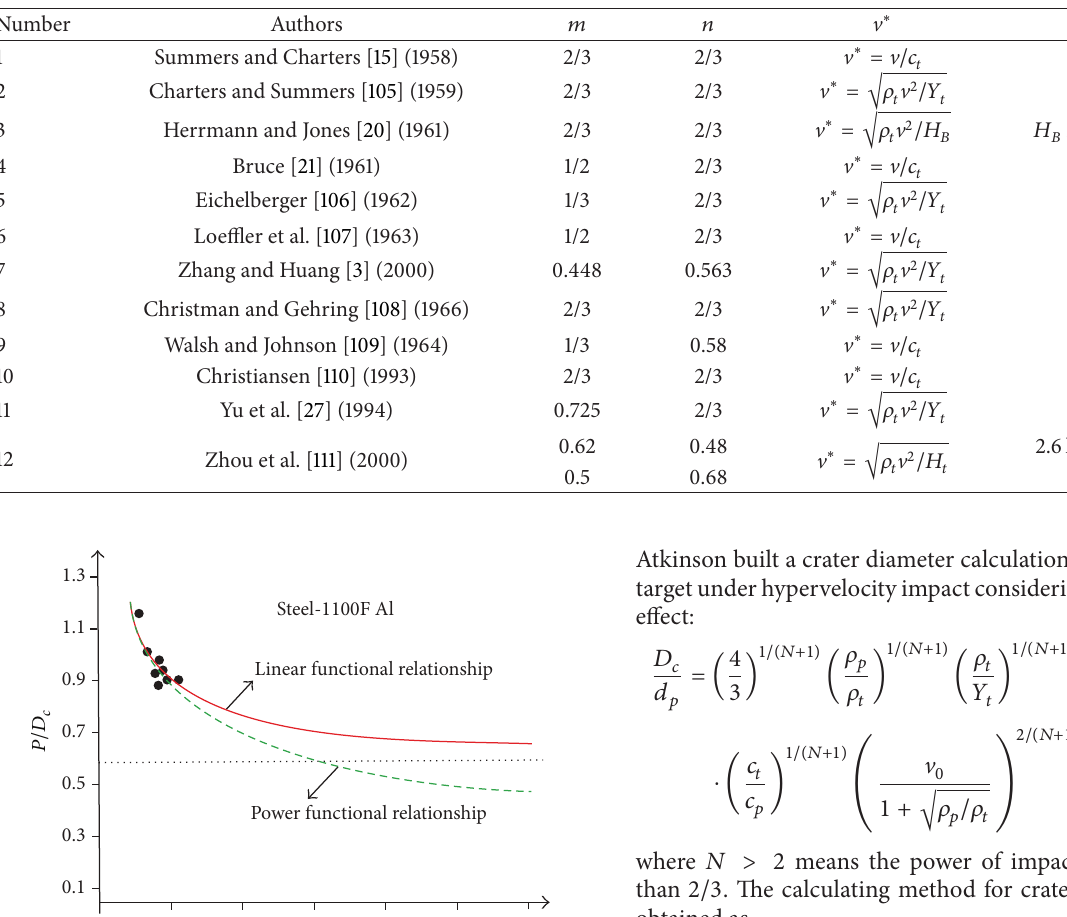
Table 3: The parameters value of (7).